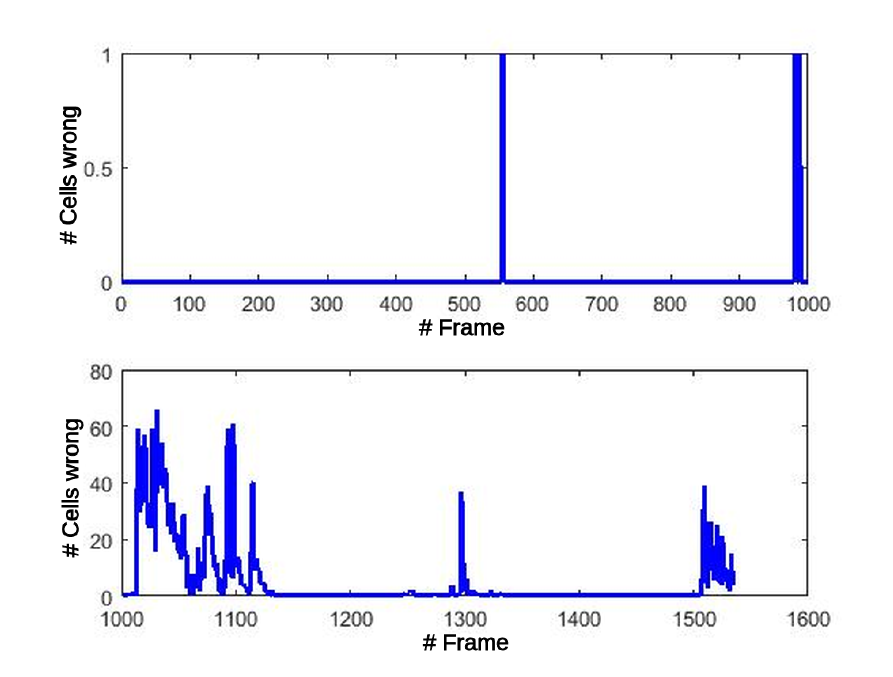
Figure 12. GPGPU errors after Motion detection stage.